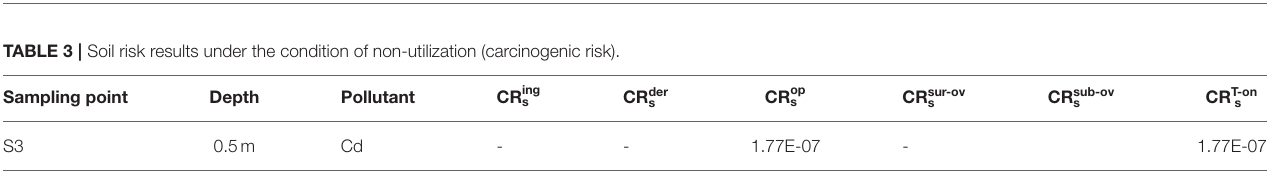
TABLE 4 | Soil risk results under the condition of non-utilization (non-carcinogenic hazard index). Sampling